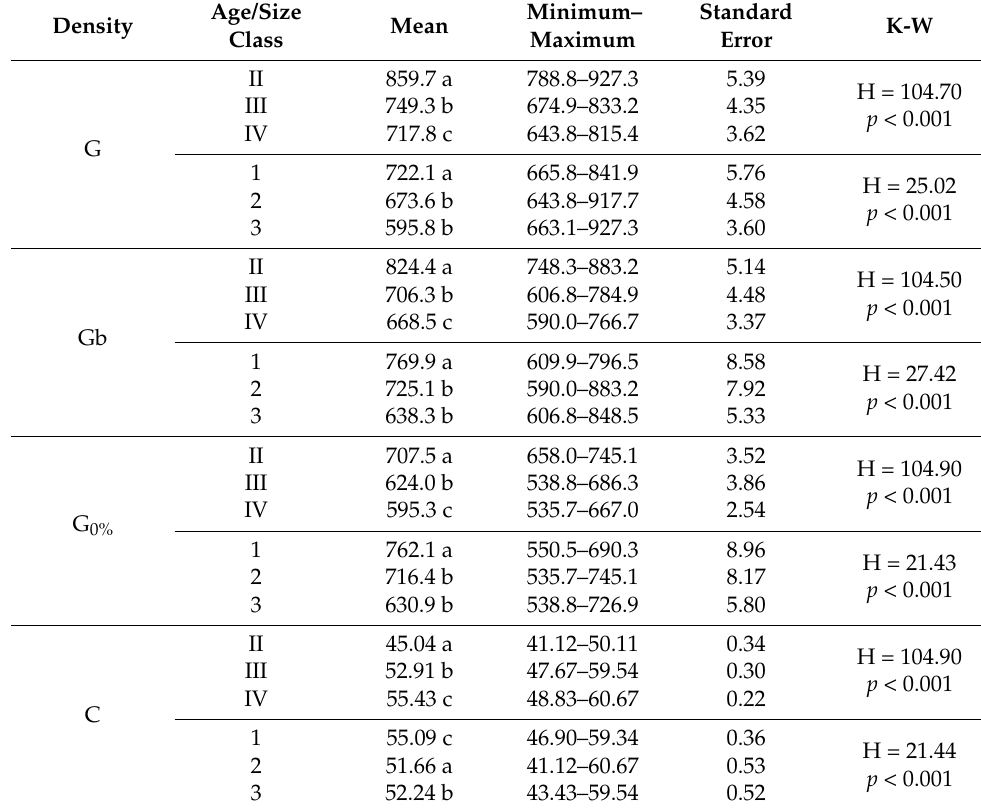
Table 2. Basic characteristics of black locust wood density (G, kg · m − 3 ), basic density (Gb, kg · m − 3 ) and oven-dry density (G0%, kg · m − 3 ) as well as porosity (C, %) in relation to tree’s age class (II–IV) and size class (1–3) as well as parameters of Kruskal–Wallis comparison